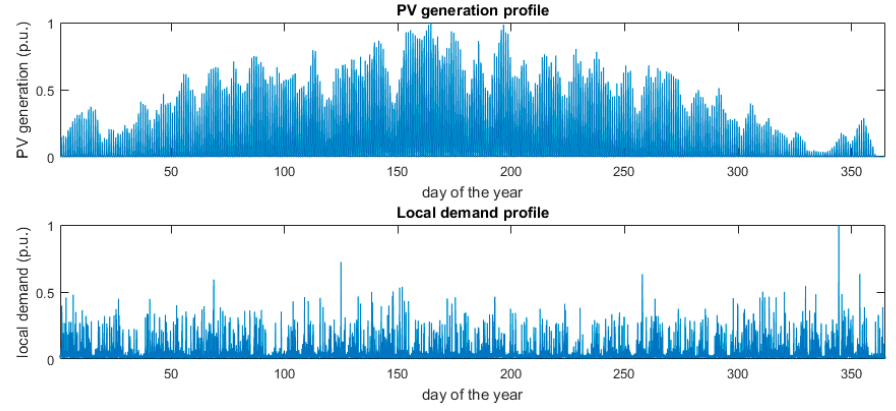
Figure A1. PV generation and load profile used for this simulation study. Both profiles are scaled